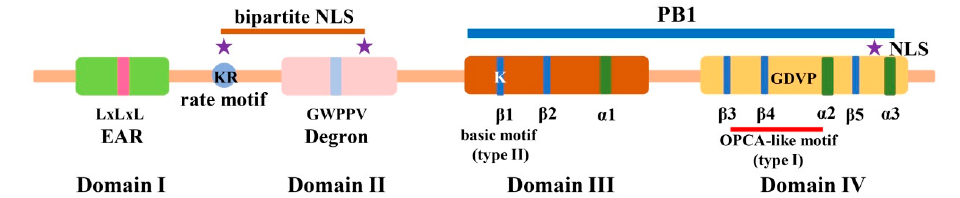
Figure 1. Domain architecture of the canonical Aux/IAA proteins. The canonical Aux/IAA proteins consist of four typical domains, namely, Domains I–IV. Domain I contains an “LxLxL” motif, which is called the ethylene response factor (ERF)-associated amphiphilic repression (EAR) motif. Between Domain I and II, a conserved “KR” motif was identified as a rate motif, and a bipartite nuclear localization signal (NLS) was located between the KR motif and Domain II. The “GWPPV” motif in Domain II is a degron, which controls the turnover of Aux/IAA proteins. Domain III and IV together form type I/II Phox and Bem1p (PB1) domains. Domain III comprises β 1, β 2, and α 1, and the conserved “K” residue in β 1 has been identified as a type II basic motif of PB1. Domain IV contains three β -sheets ( β 3– β 5) and two α -helices ( α 2 and α 3). One OPCA-like motif in this domain forms the other face of the ePB1 domain, and a conserved “GDVP” motif between β 4 and α 2 may facilitate electrostatic protein interactions. Another NLS was also observed in this domain [5,44,60]. Although most Aux/IAA proteins harbor the typical four domains, a considerable number of truncated Aux/IAA proteins have also been found in different plant species (Table 1). For instance, two Aux/IAA proteins (AtIAA29 and AtIAA33) in Arabidopsis , three Aux/IAA proteins (SlIAA13, SlIAA16, and SlIAA20) in tomato, and five Aux/IAA proteins (StIAA13, StIAA15, StIAA16, StIAA18, and StIAA20) in potato lack Domains I and II [29,34]. Meanwhile, some truncated proteins without Domain III or IV have been identified, such as CpIAA11, CpIAA19, CpIAA27, and CpIAA31 from Carica papaya [47]. Additionally, a large proportion of truncated Aux/IAA proteins have been found in Amborella trichopoda , Cicer arietinum , Phalaenopsis equestris , Picea abies , Selaginella moellendorffii , and